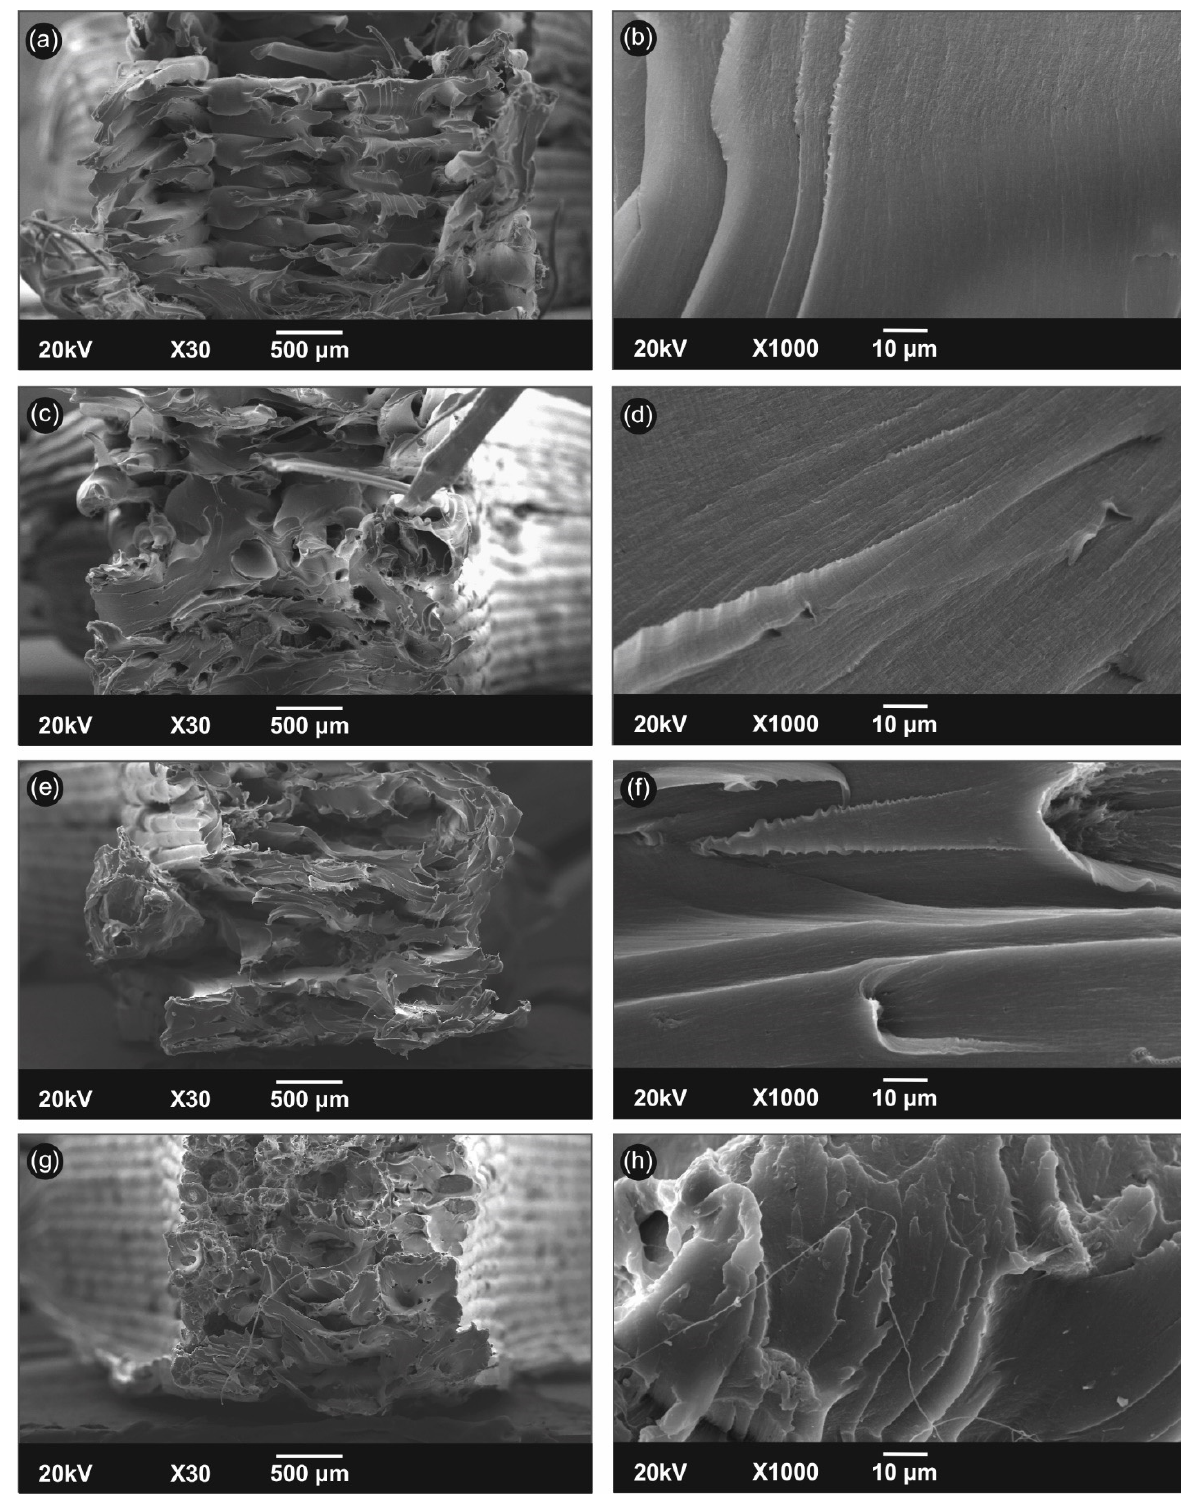
Figure 10. Fractured surface morphology of PA12/CNT 3D ‐ printed nanocomposites after tensile tests: neat PA12 ( a , b ) compared to 2.5 wt.% ( c , d ), 5.0 wt.% ( e , f ), and 10.0 wt.% ( g , h ) filler loading.